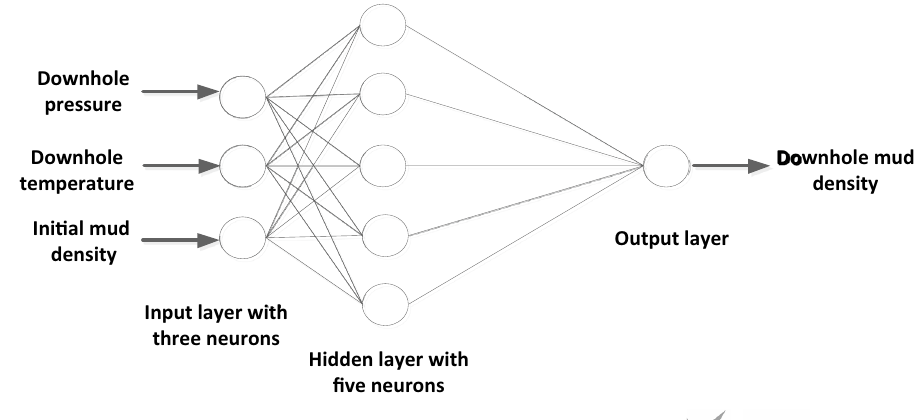
Fig. 1 Optimal architecture